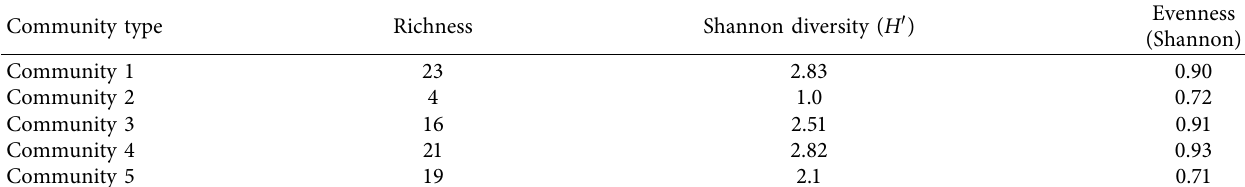
Table 2: Plant species richness, Shannon diversity, and evenness indices of the fve community types.